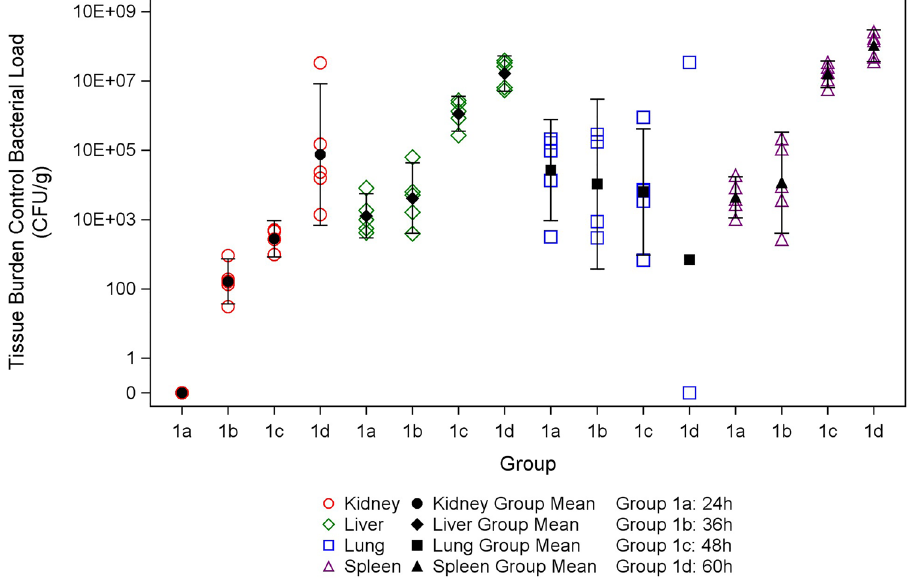
Figure 2. Observed bacterial load data (CFU/g) with mean and 95% confidence interval in untreated animals. Individual, mean, and 95% confidence intervals of CFU/g in the kidney, liver, lung, and spleen of untreated infected animals at 24, 36, 48, and 60 h post-exposure. All tissue specimens contained B. pseudomallei apart from three kidney samples at 24 h post-exposure and two lung samples at 60 h post-exposure. CFU/g in the kidney samples obtained at 36 h post-exposure was less than the lower limit of quantitation of the assay.